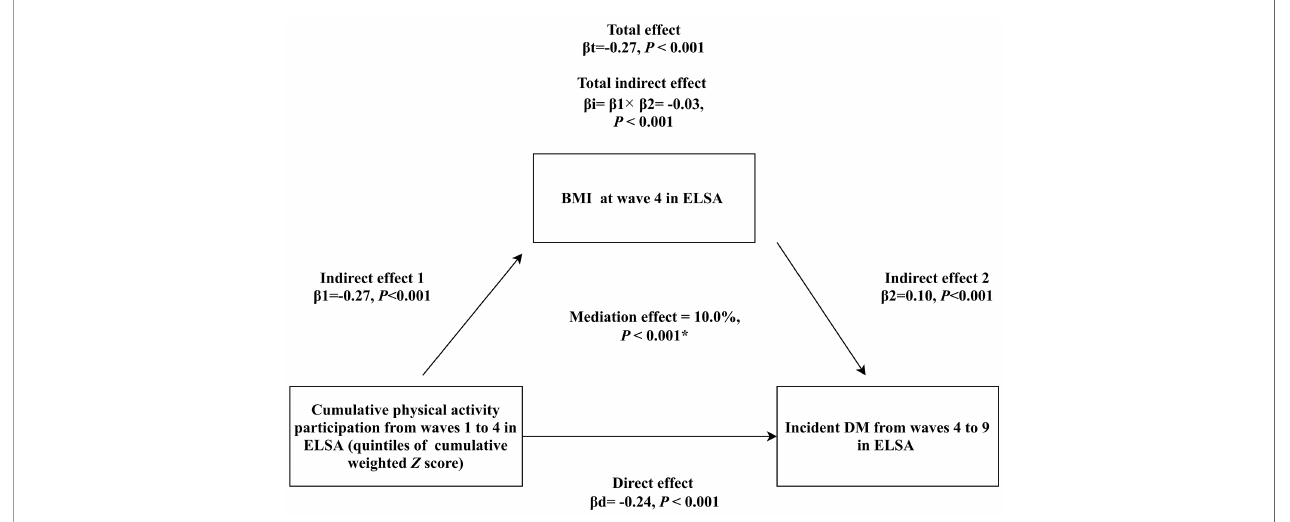
FIGURE 3 | Mediation analysis assessing the mediating role of BMI measured at wave 4 in the association of cumulative weighted global physical activity Z score quintiles on subsequent incident DM. b d: coef fi cient for direct association of cumulative weighted global physical activity Z score quintiles on subsequent incident